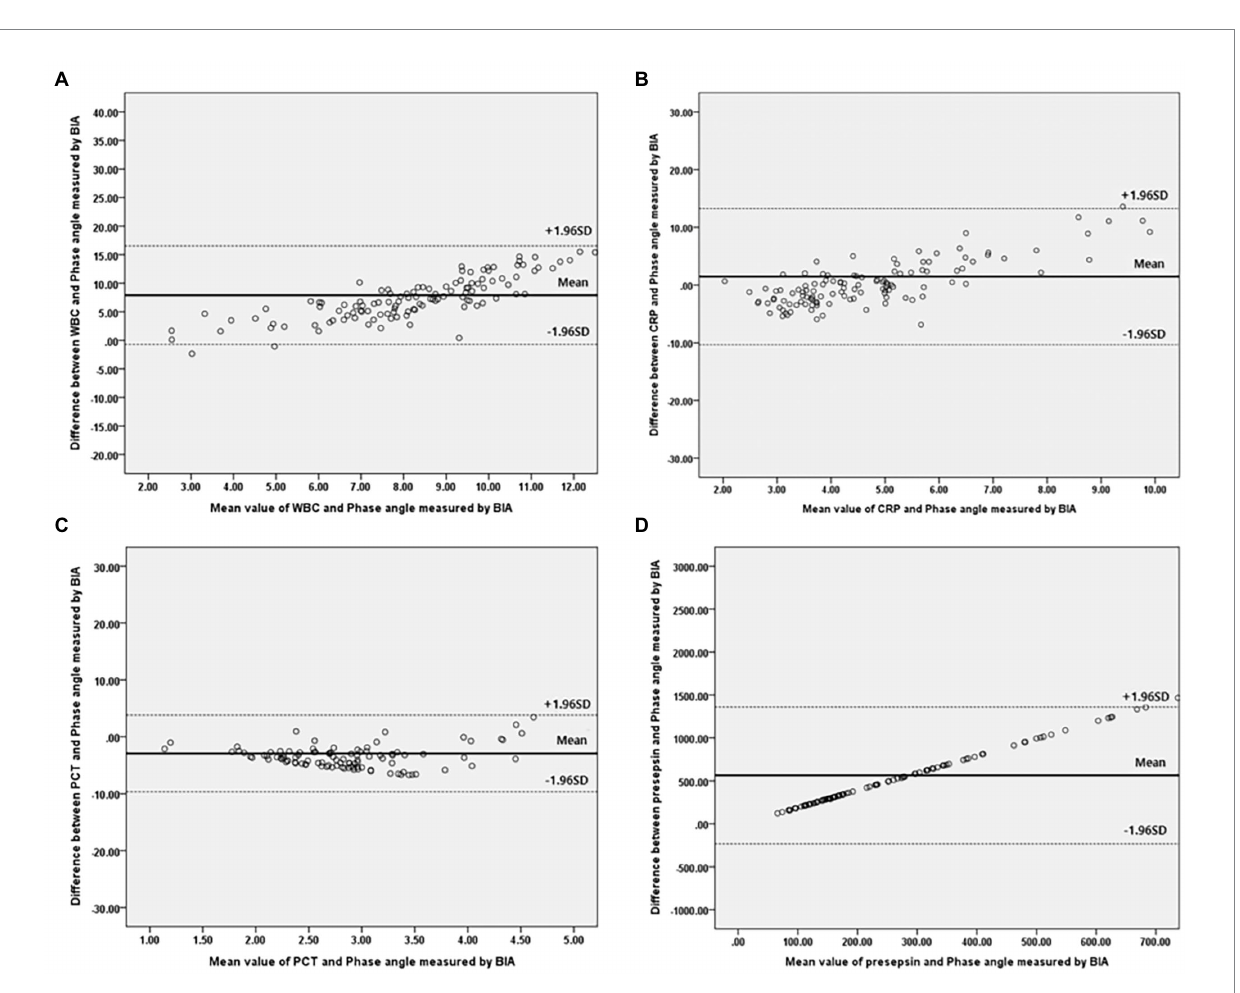
FIGURE 3 Bland–Altman plot for analyzing the agreement between the inflammatory marker and Phase angle on BIA in males. (A) White blood cell, (B) C-reactive protein, (C) Procalcitonin, (D) Presepsi. *BIA: bioelectrical impedance